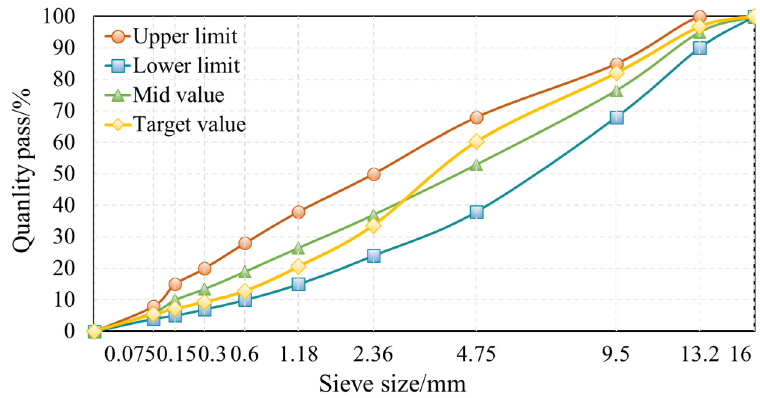
Figure 2. Synthetic gradation of aggregate (AC-13). Table 6. Results of OAC and the corresponding parameters.